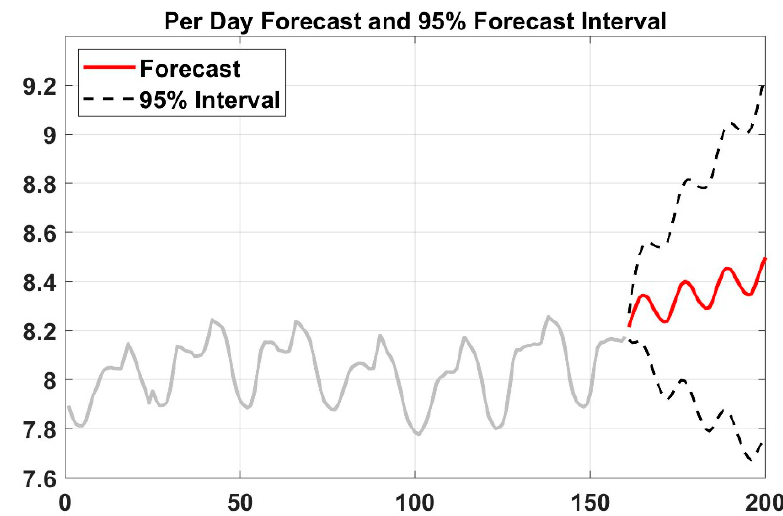
Figure 24. Per hour forecasting validation using MC.